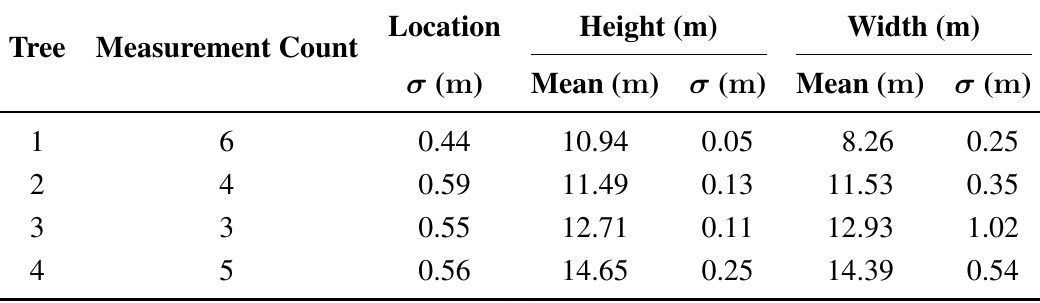
Table 5. Mean and Standard deviations ( σ ) of individual tree metrics derived from the ( a ) full density point clouds and ( b ) the point clouds decimated to 8 points per m 2